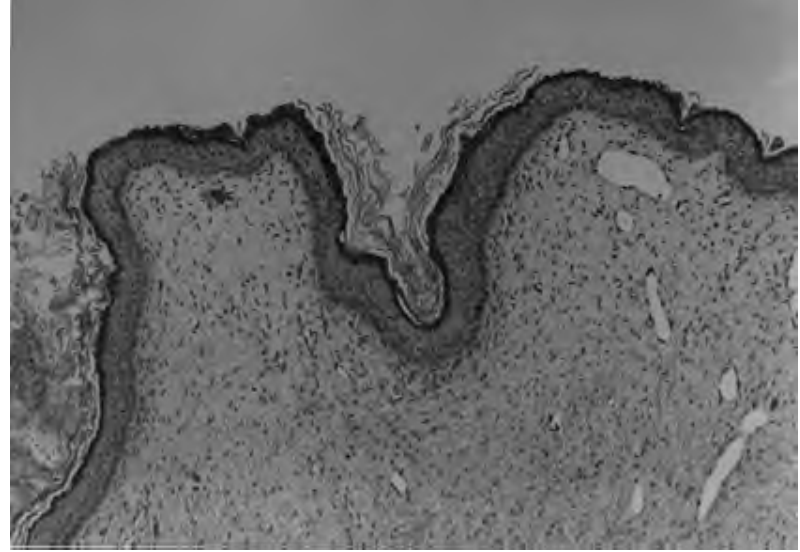
FIGURE 3 . Microscopic examination of the bladder illustrating hypertrophy of the muscularis propia from chronic